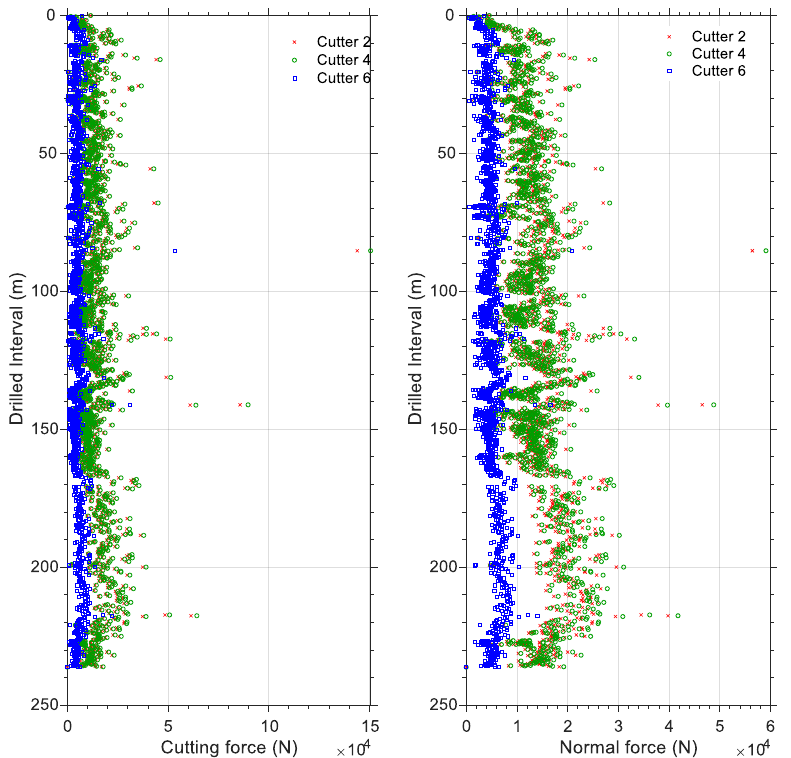
Figure 16. Specific energy ( left ) and torque ( right ) plots for the bit run number 2 for three equivalent cutters; i.e., 1, 5, and 9.